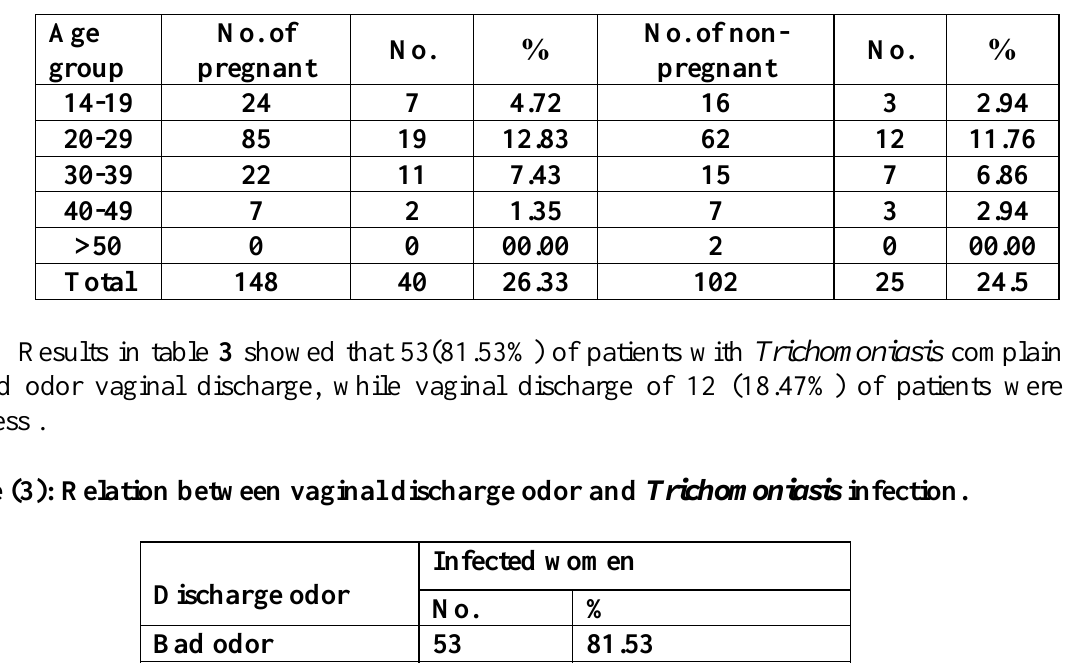
Table (2): Relation between age group and infection with T. Vaginalis.